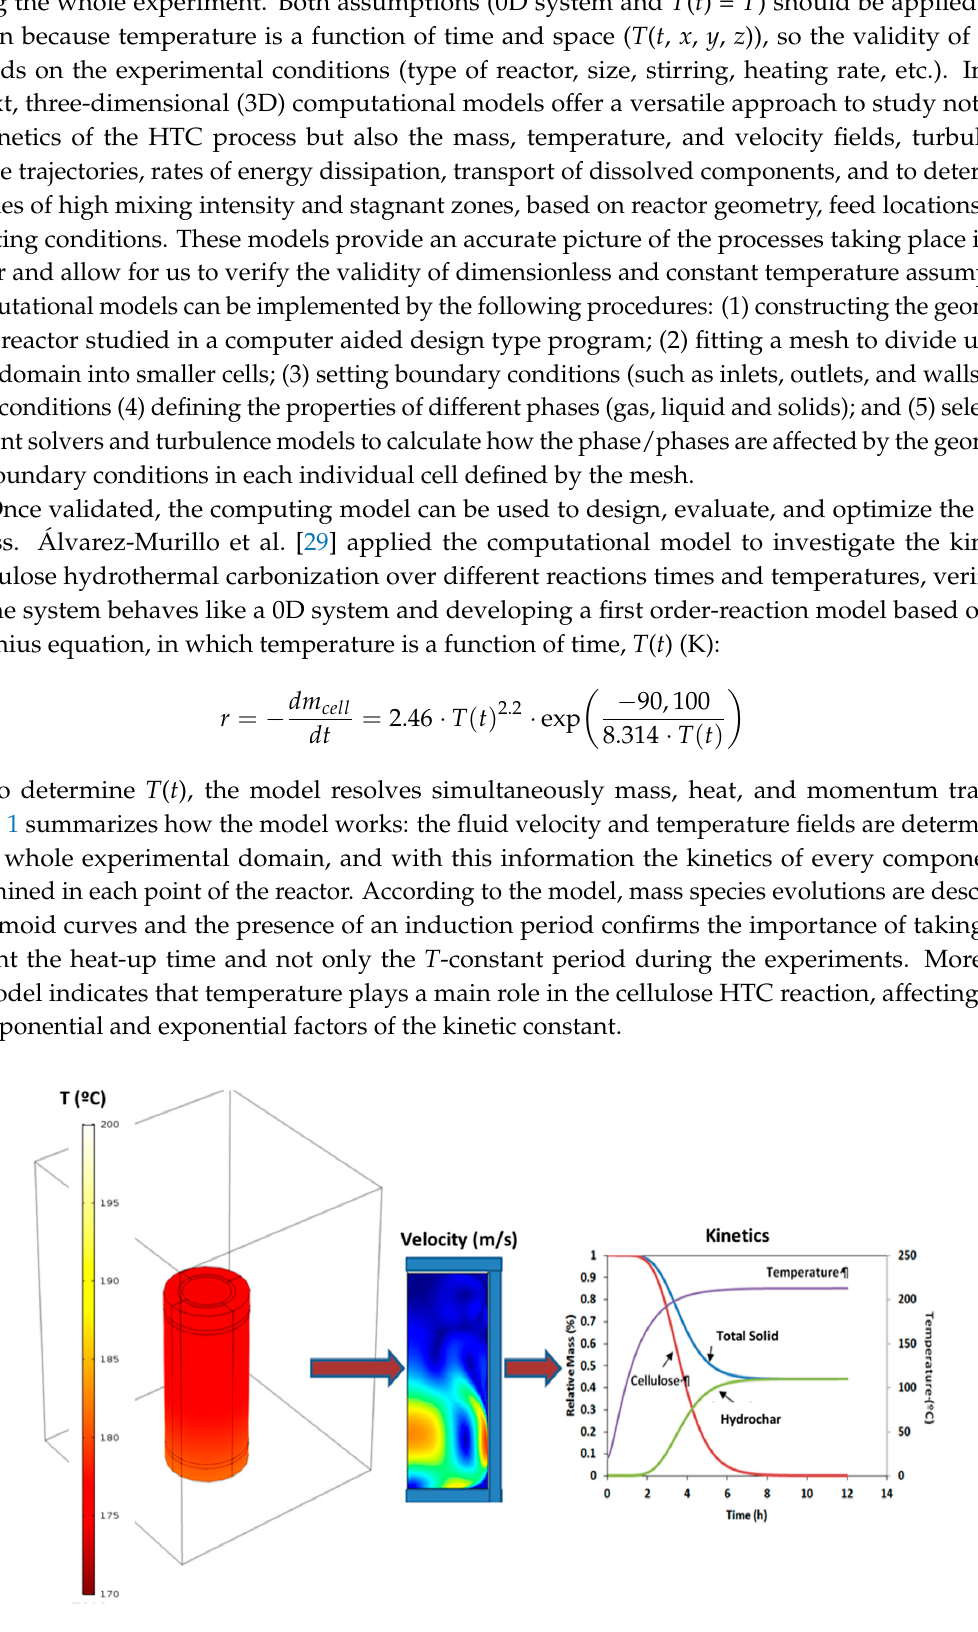
Figure 1. Computational model summary.